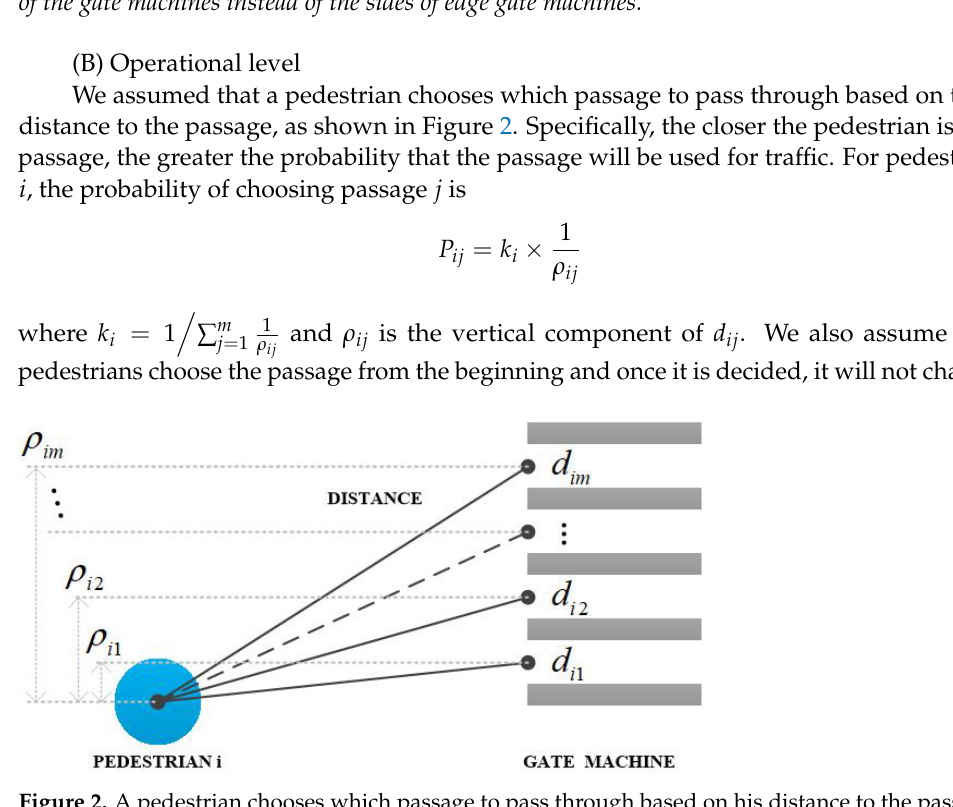
Figure 2. A pedestrian chooses which passage to pass through based on his distance to the